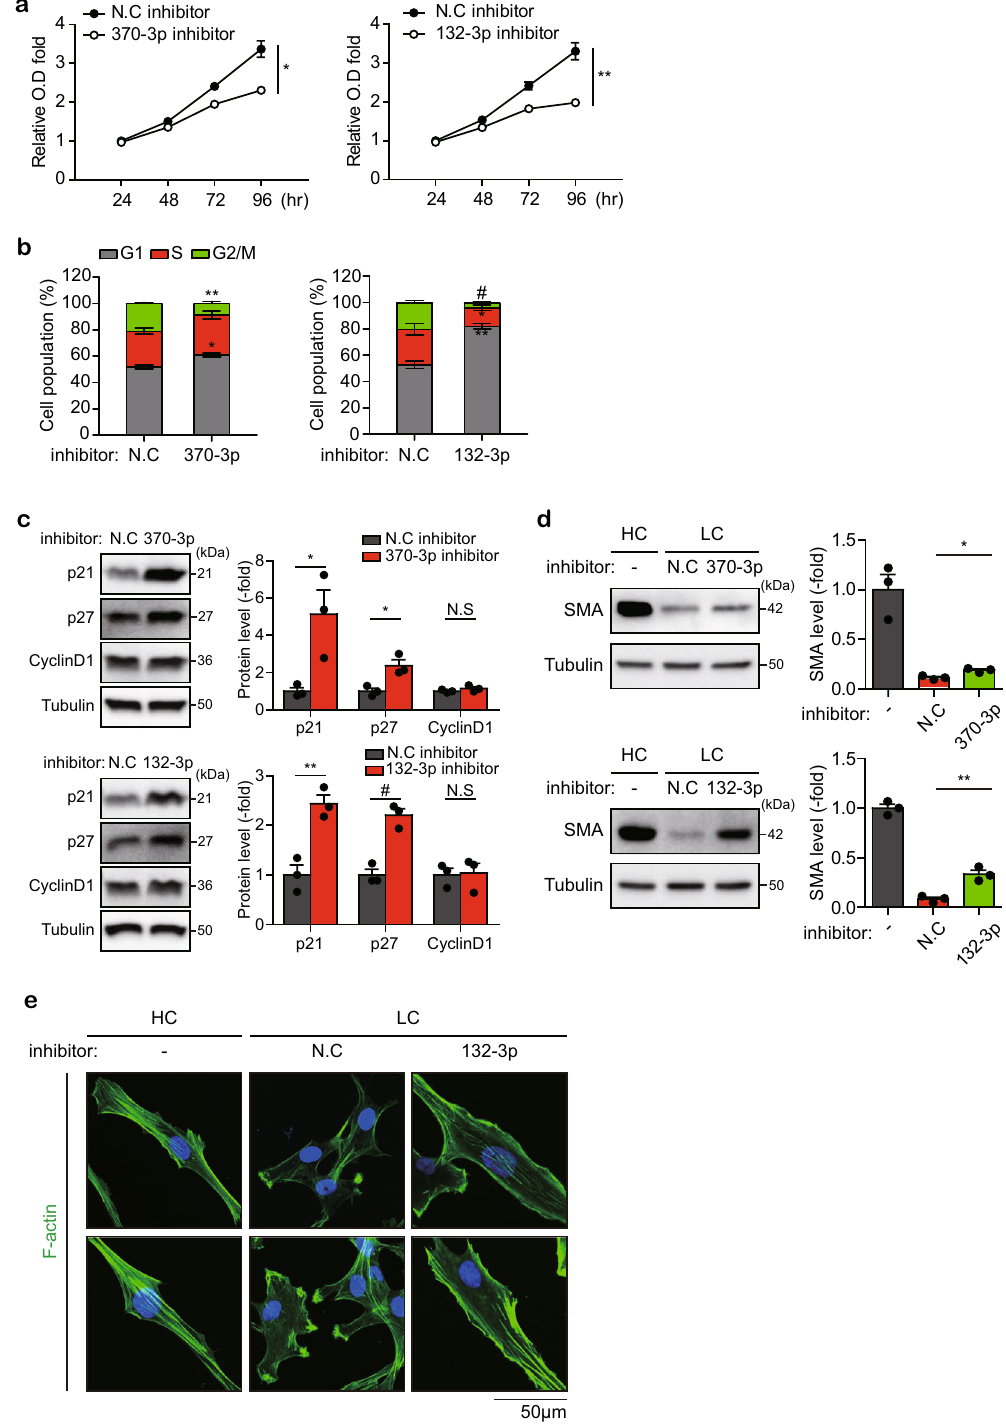
Figure 3. Roles of the selected DE-miRNAs in the SMC functions. ( a ) Effects of miR-370-3p or miR-132-3p on the proliferation rates of HASMCs. Data in the graphs are means ± SEM of the formazan absorbance at 450 nm after subtracting the absorbance at 600 nm as a reference ( n = 3, * P < 0.05, ** P < 0.005). ( b ) Effects of miR-132-3p and miR-370-3p on the cell cycle progression of HASMCs. Data in graphs are means ± SEM of the percentage of cells at each phase ( n = 3, * P < 0.05, ** P < 0.005, # P < 0.001). ( c ) Effects of miR-132-3p and miR-370-3p on the expression of cell cycle proteins in HASMCs. Data in graphs are means ± SEM of relative fold changes of the band intensities normalized by the intensity of tubulin band ( n = 3, * P < 0.05, ** P < 0.01, # P < 0.002). N.S., not significant. ( d ) Effects of miR-132-3p and miR-370-3p on the cell density-dependent phenotypic change of HASMCs. Highly-confluent (HC) culture of the miRNA inhibitor-transfected HASMCs were re-plated at a low confluence (LC, 8000 cells /cm 2 ) and subjected to immunoblot analysis after 4-days culture. Data in graphs are means ± SEM of relative fold changes of the band intensities of α-smooth muscle actin (SMA) normalized by the tubulin intensity ( n = 3, * P < 0.01, ** P < 0.005). ( e ) Effects of miR-132-3p on the cell density-dependent cytoskeletal arrangements in HASMCs. The miRNA inhibitor-transfected HASMCs were stained with phalloidin (green). DAPI (blue) labels nuclei. Representative images are shown ( n =